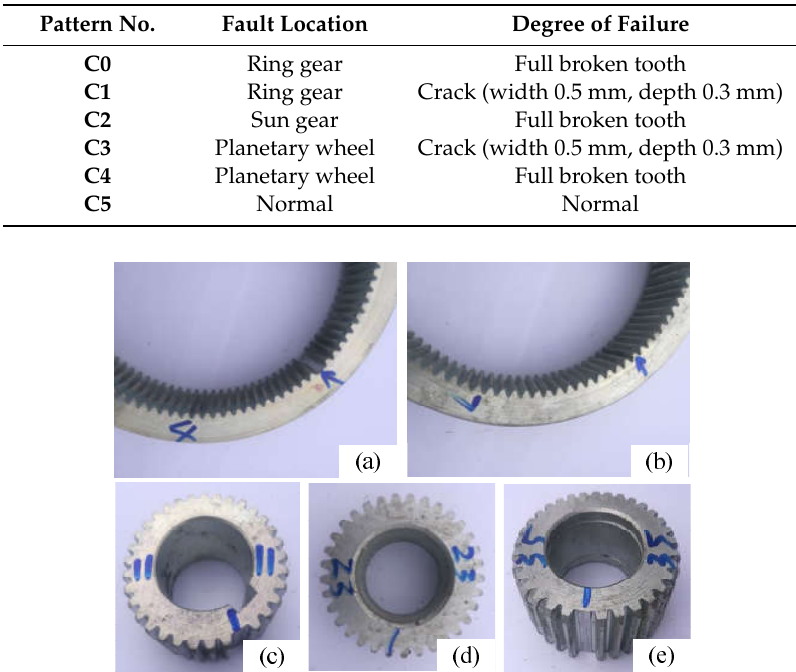
Table 1. Details of the faulty patterns in the experiments.